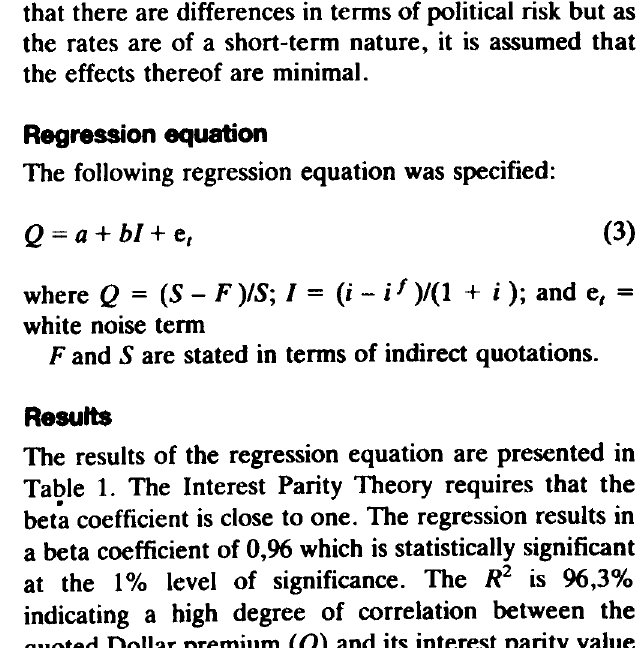
Figure 2 Interest parity